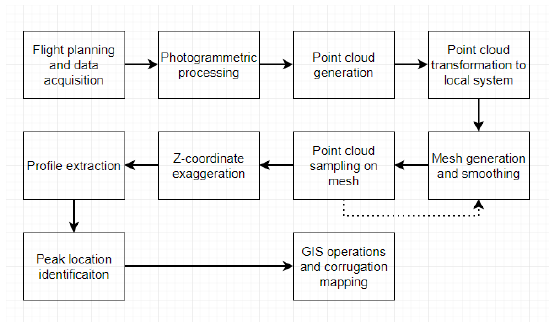
Figure 3: Methodological flow diagram